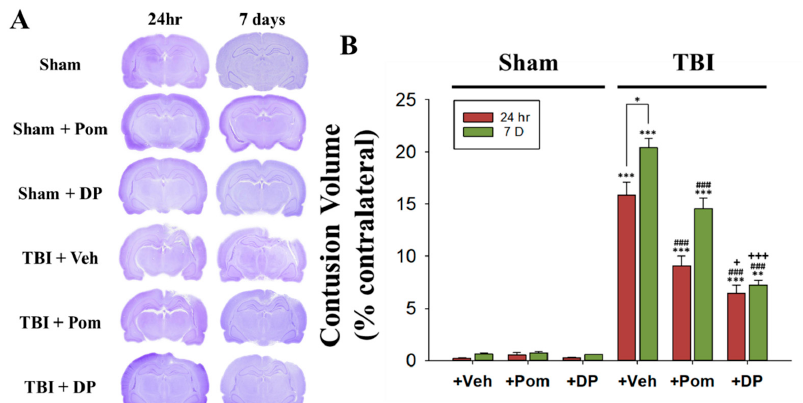
Figure 2. DP was more effective regarding the contusion volume reduction than Pom at 24 h and 7 days after a TBI. ( A ) Representative images of cresyl-violet-stained coronal brain sections from Sham + Veh, Sham + Pom, Sham + DP, TBI + Veh, TBI + Pom and TBI + DP rats at 24 h and 7 days after a TBI. ( B ) The contusion volume measured at 24 h and 7 days after a TBI was significantly reduced due to the administration of DP or Pom. Data are expressed as the mean ± S.E.M. * p < 0.05; ** p < 0.01; *** p < 0.001 versus the Sham + Veh group at the same time points versus different time points in the same group; ### p < 0.001 versus the TBI + Veh group at the same time point; + p < 0.05, +++ p < 0.001 versus the TBI + Pom group at the same time point ( n = 5 in each group). Statistical differences were analyzed using independent sample t-tests and one-way ANOVA, followed by Tukey’s post hoc